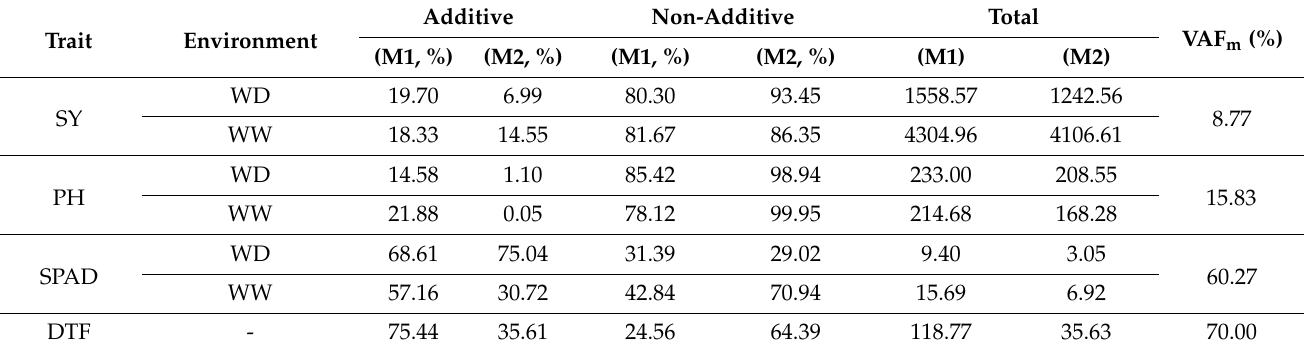
Table 1. Summary of the partitioning of the genetic variance into Additive and Non-additive and the residual maximum likelihood estimates of the Total (additive plus non-additive) genetic variance before (Baseline factor analytic linear mixed model with markers: M1) and after identifying putative QTL (Final multi-QTL model: M2) for each of the traits. VAF m shows the percentage of genetic variance accounted for by the identified putative QTL. Trait variations for SY, PH, and SPAD were assessed considering the two watering blocks as two environments, whereas for DTF, it was evaluated considering them as a single environment; SY: Seed yield, PH: Plant height; SPAD: Chlorophyll content; DTF: Days to flower; WD: Water-deficit block; WW: Well-watered block. Seed yield is predicted at the average value of 9.6 plants per plot for WW block and 6.3 plants per plot for WD block.